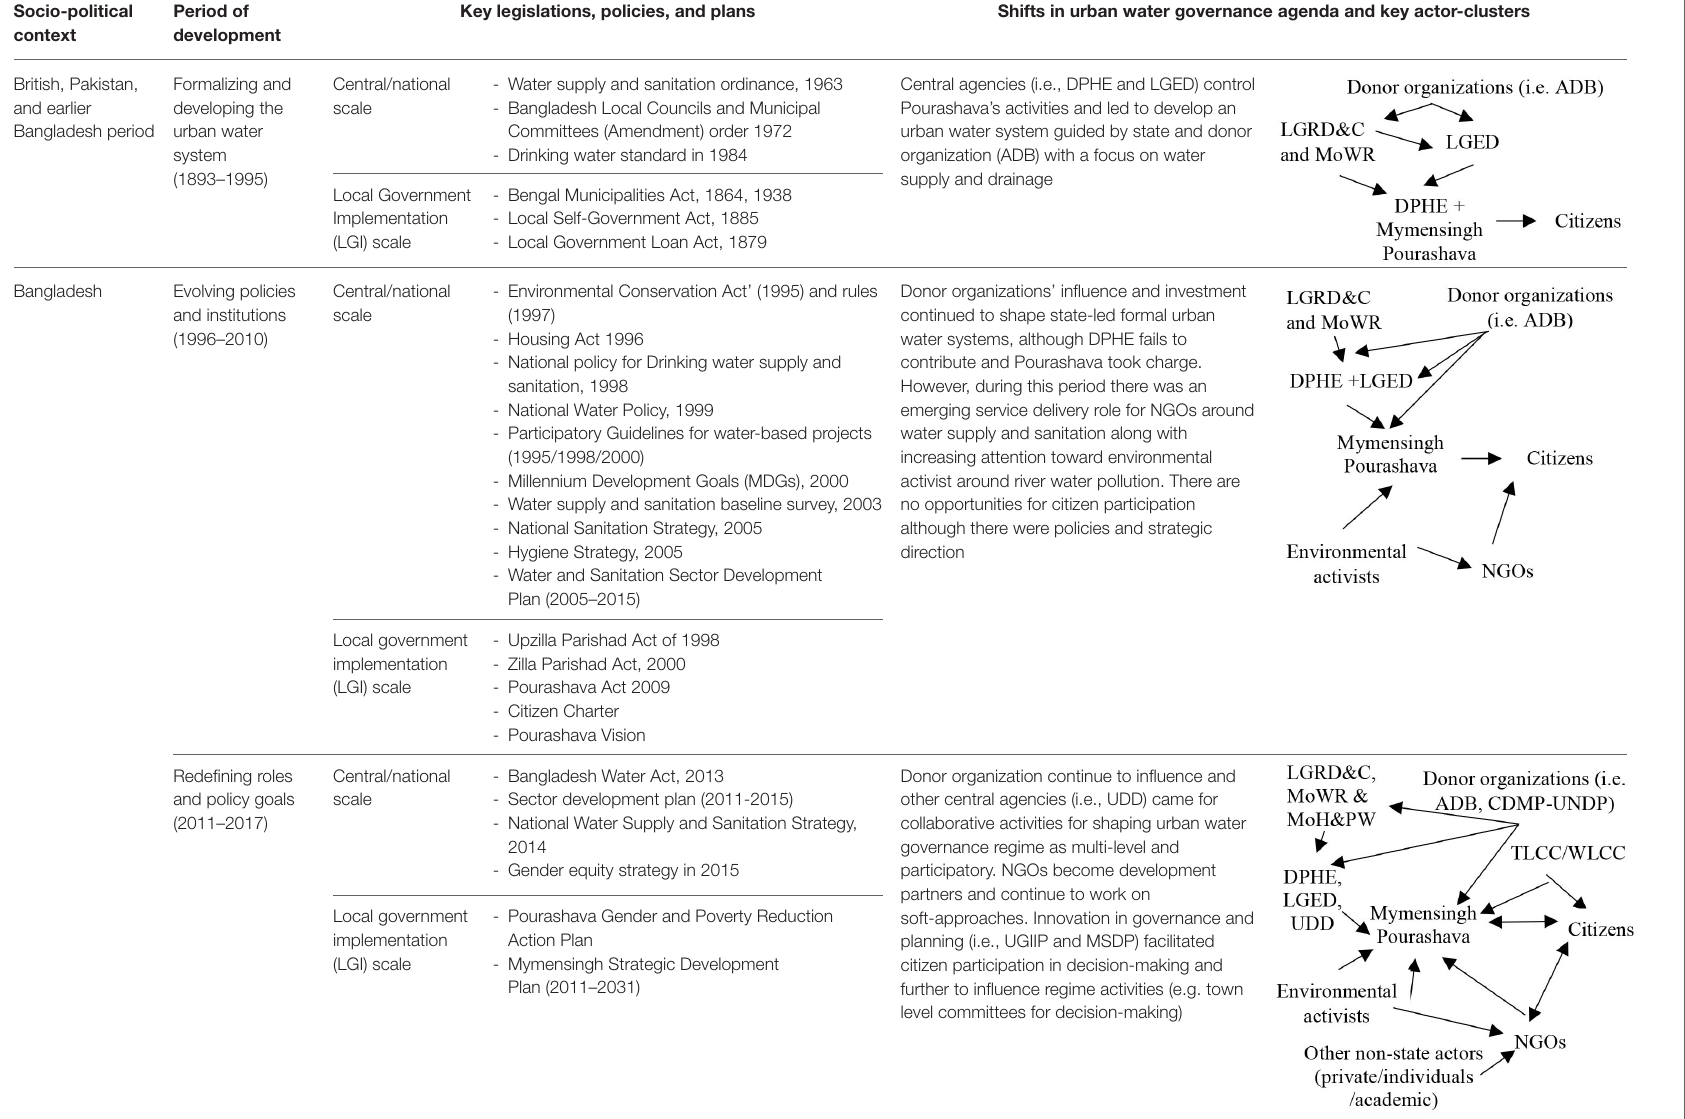
TABLE 2 | The evolution of governance approaches and actor clusters influencing Mymensingh urban water